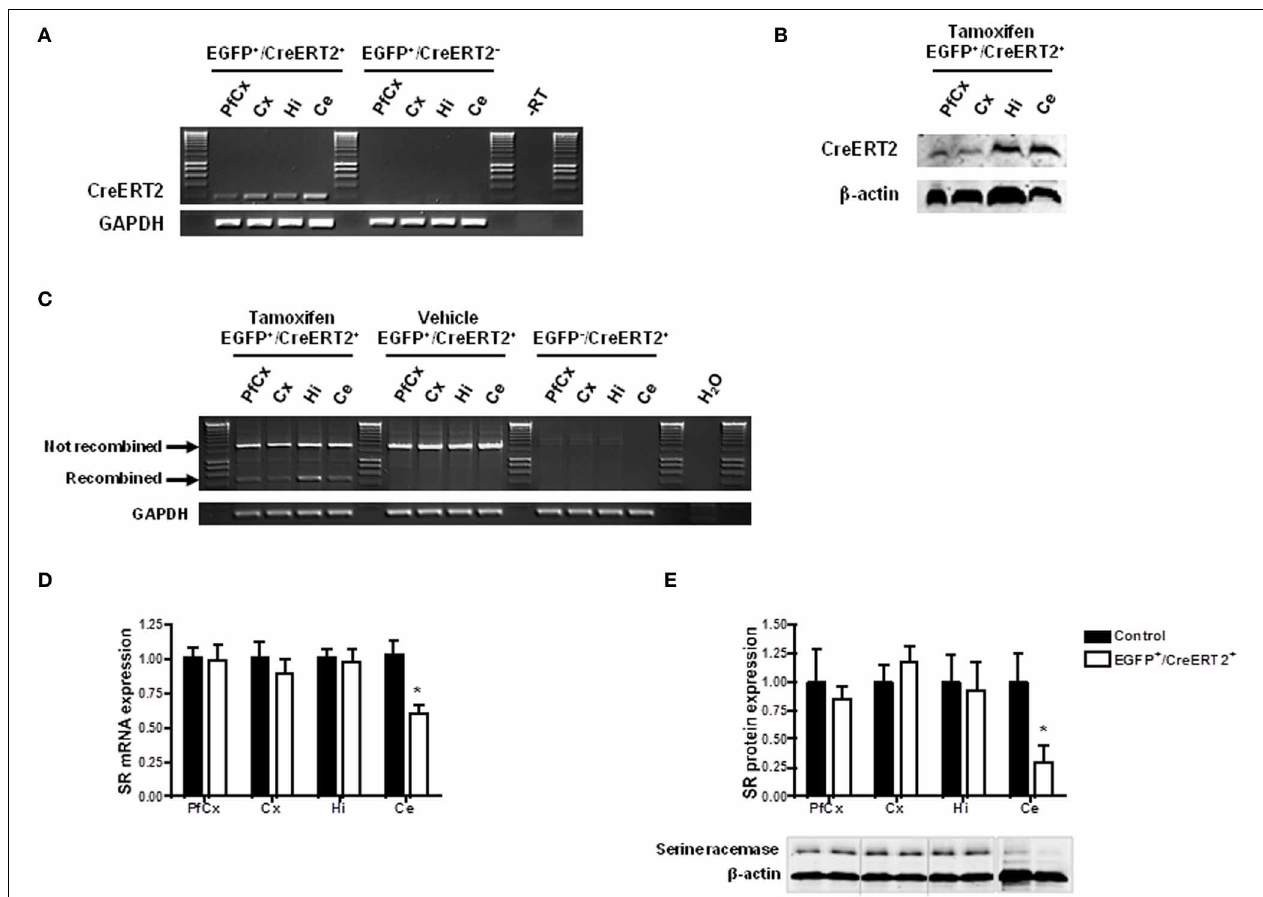
Real-time quantitative RT-PCR showing a significant decrease in SR mRNA expression in cerebellum in pSico-shRNA3 × GFAP-CreERT2 adult mice (EGFP + /CreERT2 + , n = 8) compared to control mice (EGFP + /CreERT2 − and EGFP − /CreERT2 + , n = 8). β -actin was used as internal control. (E) SR protein level is significantly decreased in cerebellum of pSico-shRNA3 × GFAP-CreERT2 adult mice (EGFP + /CreERT2 + , n = 5) relative to control mice (EGFP + /CreERT2 − and EGFP − /CreERT2 + , n = 5). Immunoblot analysis with 15 μ g of total proteins loaded for prefrontal cortex (PfCx), cortex (Cx), hippocampus (Hi), and 25 μ g for cerebellum (Ce). β -actin was used as a loading control. ∗ p < 0 .